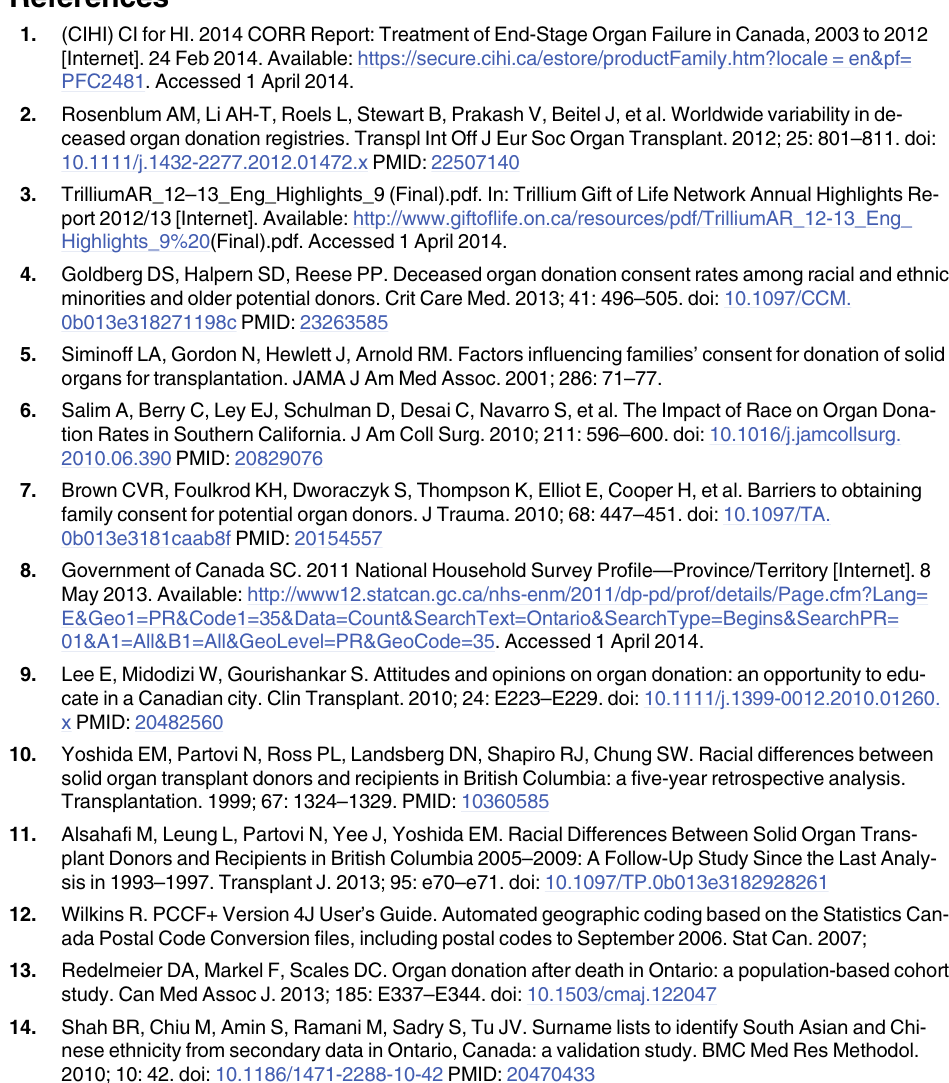
S3 Table. Factors associated with opting-out an organ and/or tissue among donor regis- trants (Cross-sectional study). S4 Table. Proportions of registered organ and tissue donors excluding organs and/or tis-